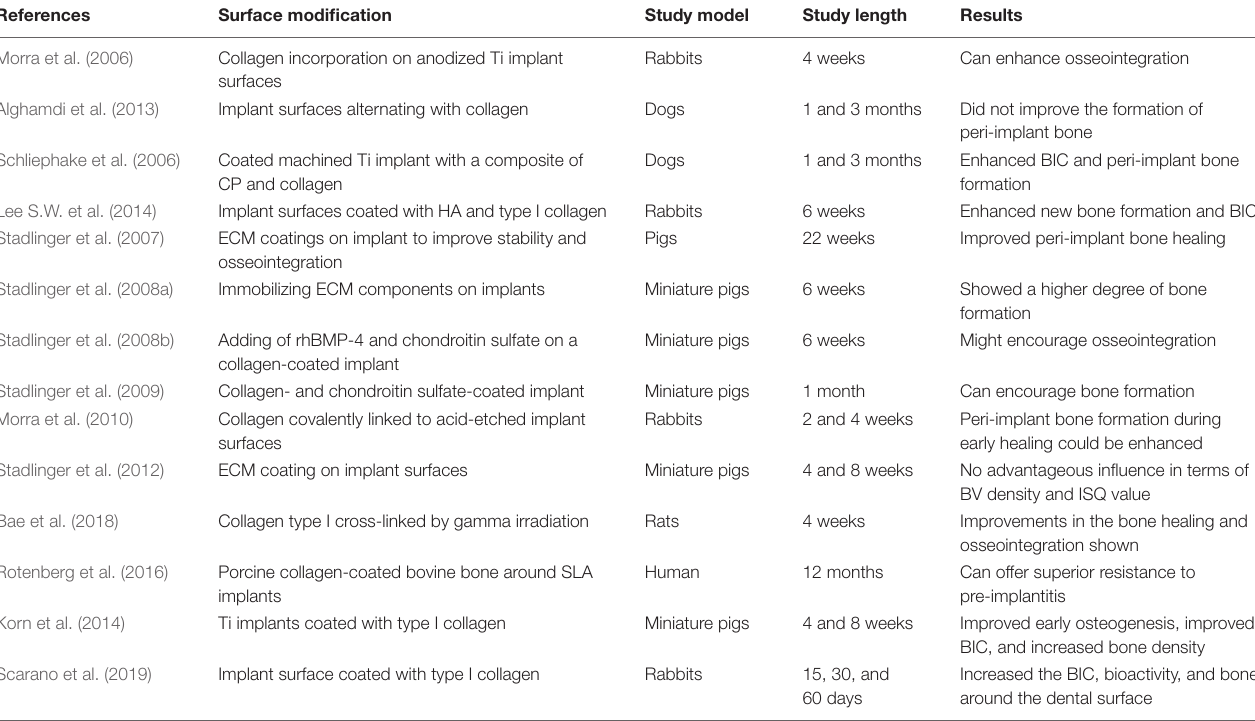
TABLE 2 | Dental implant surfaces alteration with extracellular matrix